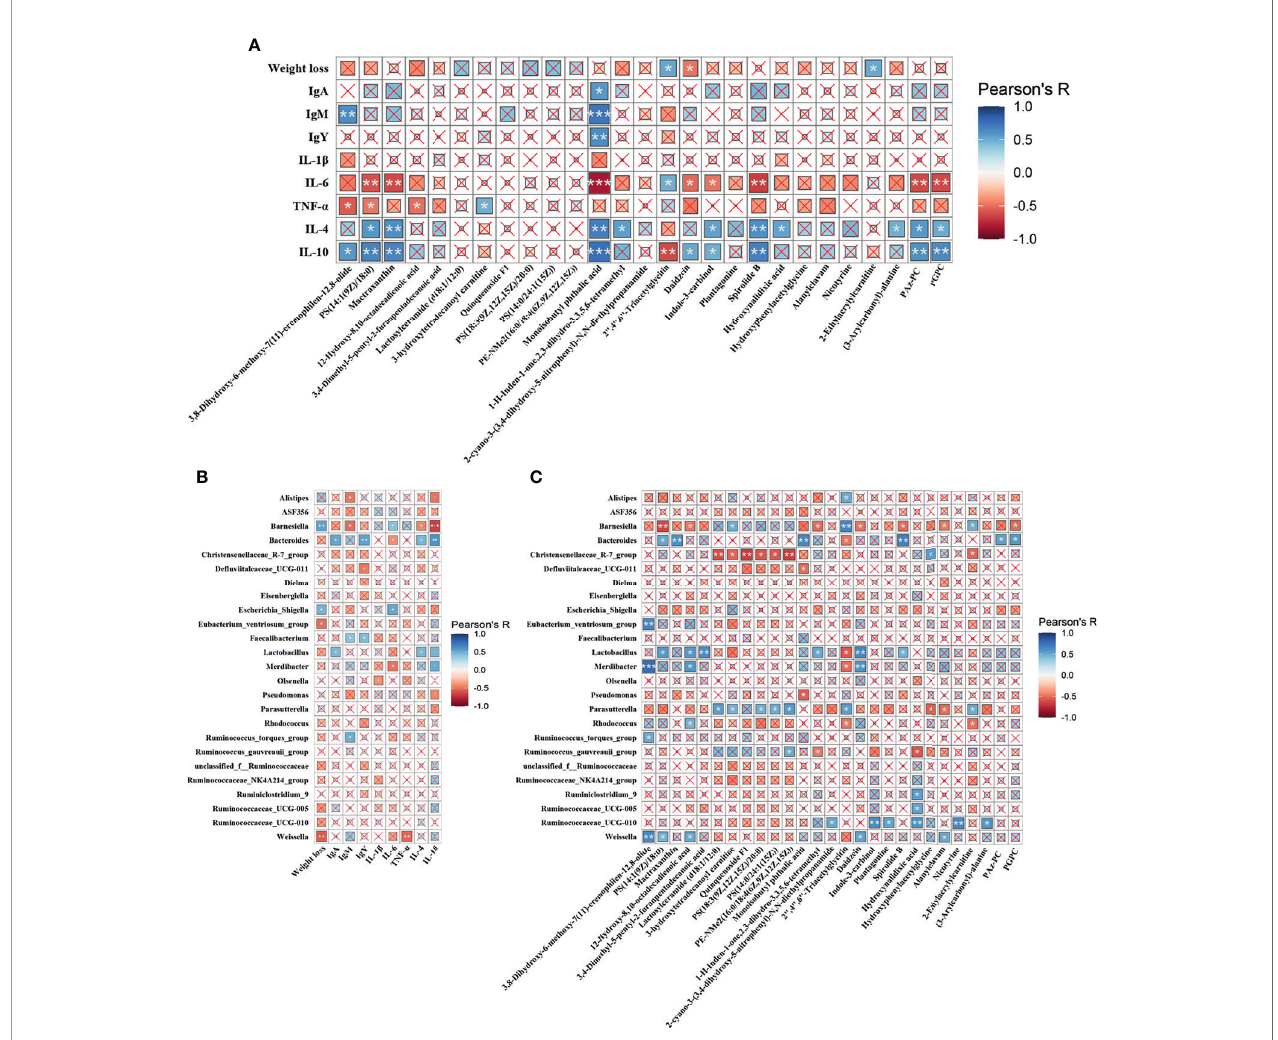
FIGURE 7 | Heatmaps of Pearson ’ s correlation. (A) Correlation between the metabolic biomarkers and immune indices. (B) Correlation between differential microbiota and immune parameters. (C) Correlation between the differential microbiota and metabolic biomarkers. The sizes of the small boxes re fl ect the correlation coef fi cient. The colors were according to the Pearson ’ s correlation coef fi cient distribution. ×P > 0.05, * P < 0.05, ** P < 0.01, *** P <